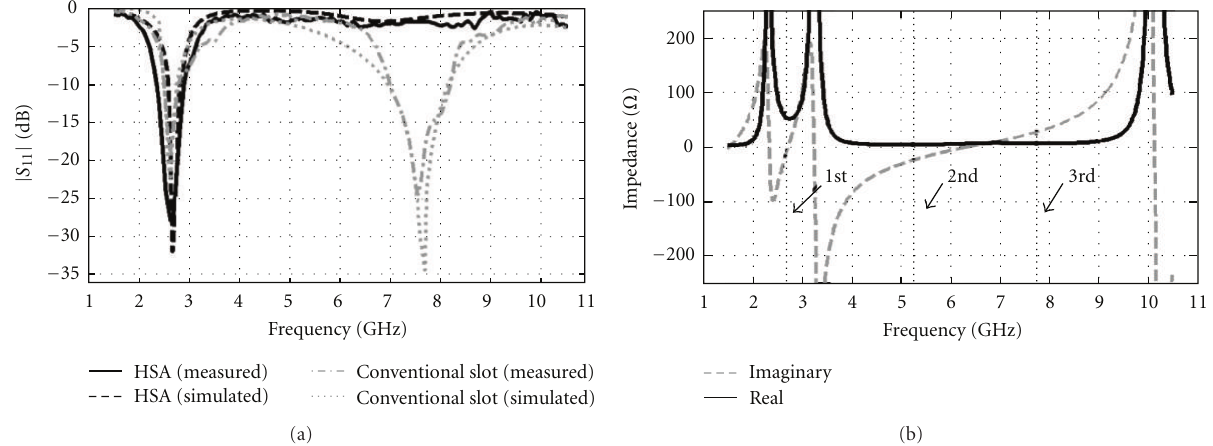
Figure 9: (a) Reflection coe ffi cients of the CDGS slot antenna and (b) measured input impedance of the CDGS slot